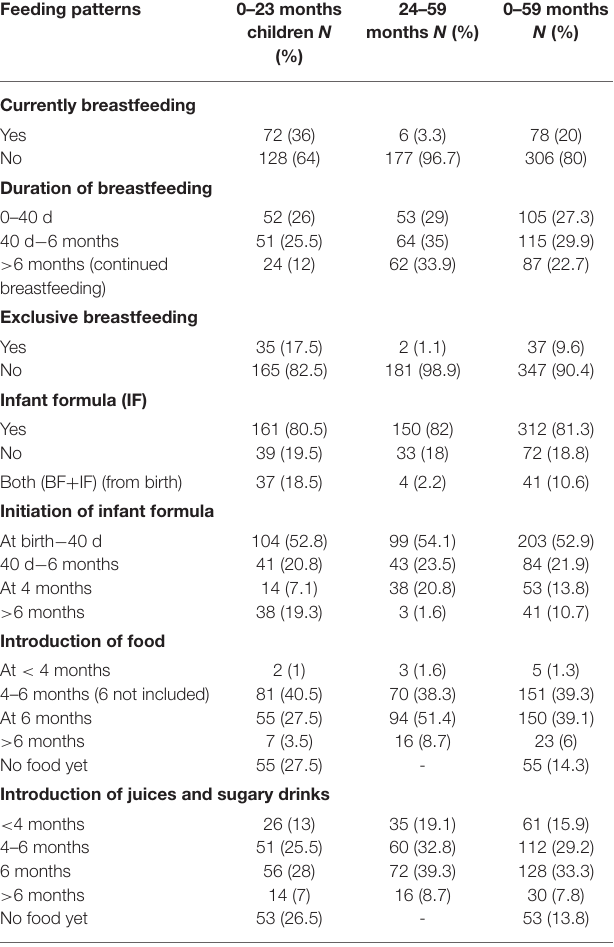
TABLE 2 | Exclusive breastfeeding, continuous breastfeeding, exclusive bottle feeding, and complementary feedings among children aged 0–23 months ( n = 200) and children aged 24–59 months ( n =